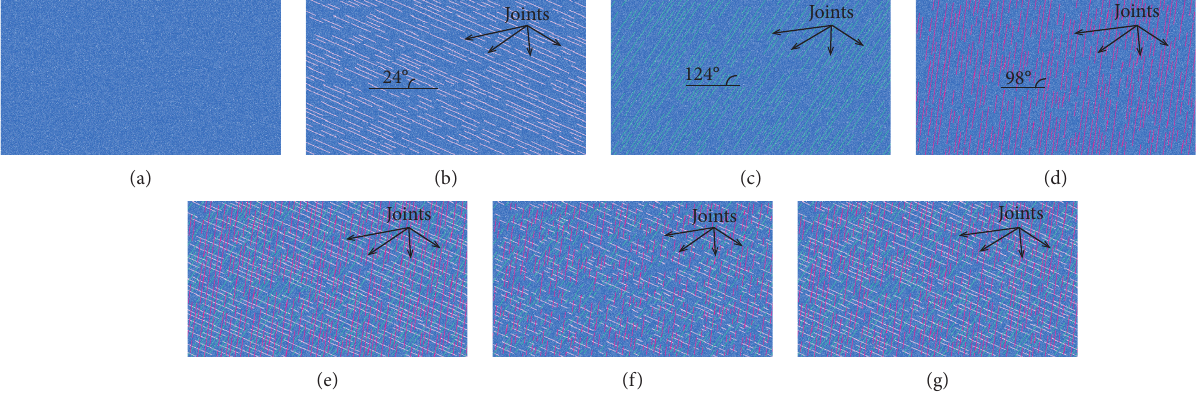
Figure 5: Numerical models. (a) No joints. (b) 24 ° joint set. (c) 124 ° joint set. (d) 98 ° joint set. (e) Joint system 1. (f) Joint system 2. (g) Joint system 3. Table 2: Joint parameters of the numerical